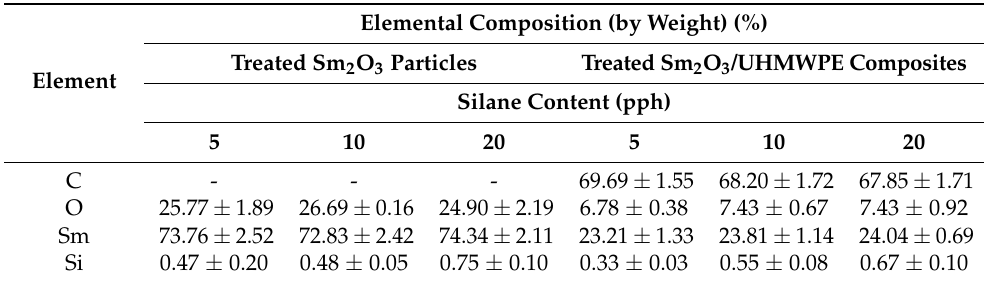
Table 8. Elemental composition of treated Sm 2 O 3 particles and treated Sm 2 O 3 /UHMWPE composites.